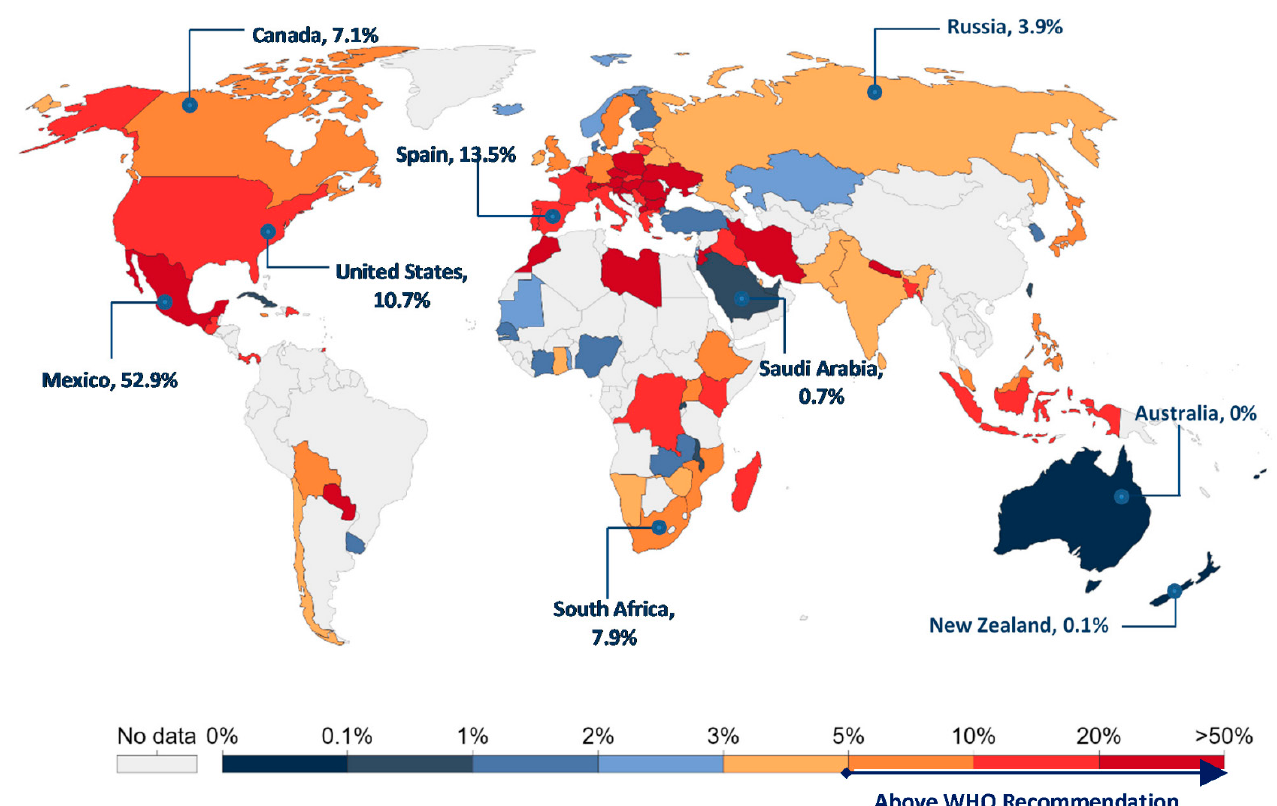
Figure 1. Worldwide map of seven-day average COVID-19 positivity rates as of 12 November 2020. Positivity rates are lowest in Australia and New Zealand and highest in countries like Mexico. Adapted from Our World in Data [6].